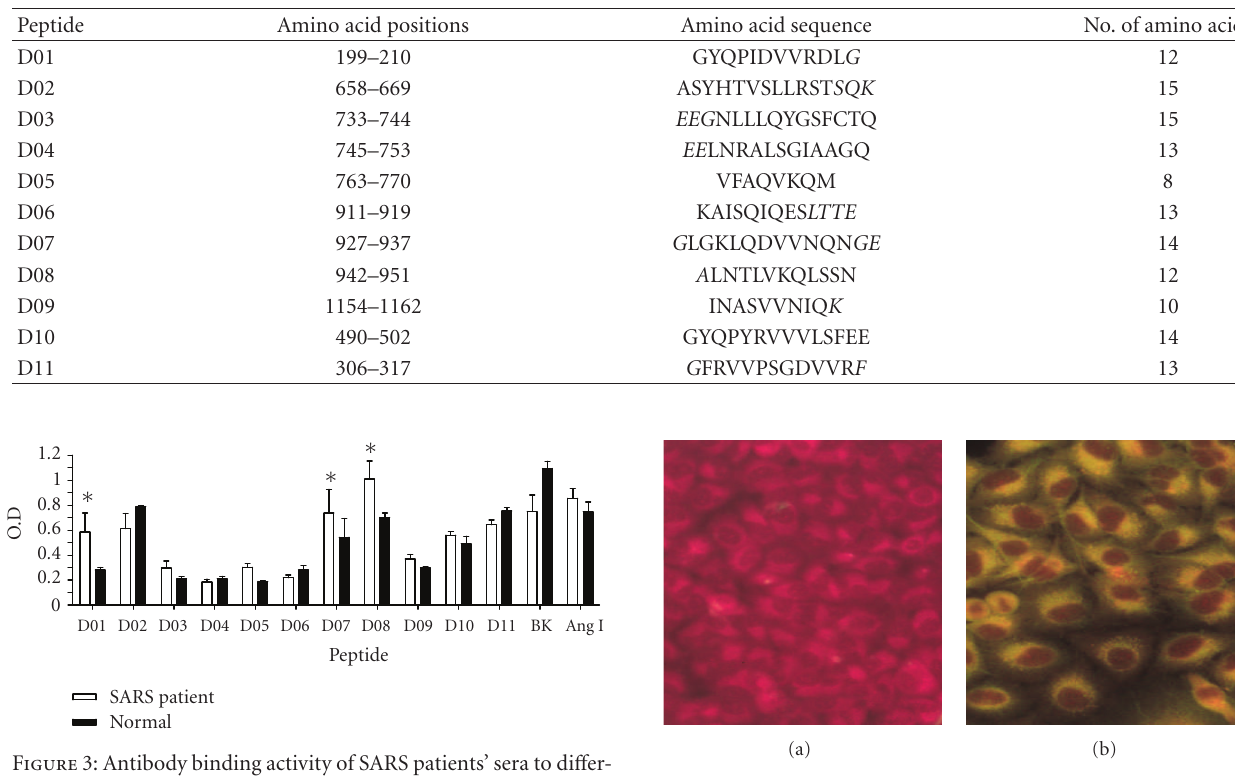
Figure 4: Immunofluorescent staining of mouse hyperimmune sera against A549 cells. A549 cells were grown on the slides and stained with secondary antibody alone (a) or mouse hyperimmune sera against D08 peptide (b) as described in Section